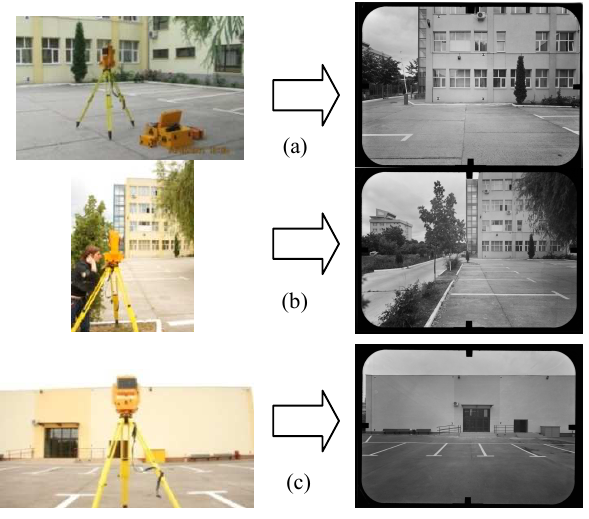
Figure 3. Data acquisition with the UMK 10/1318 photogrammetric camera (a), (b) North-East facade, (c) North facade